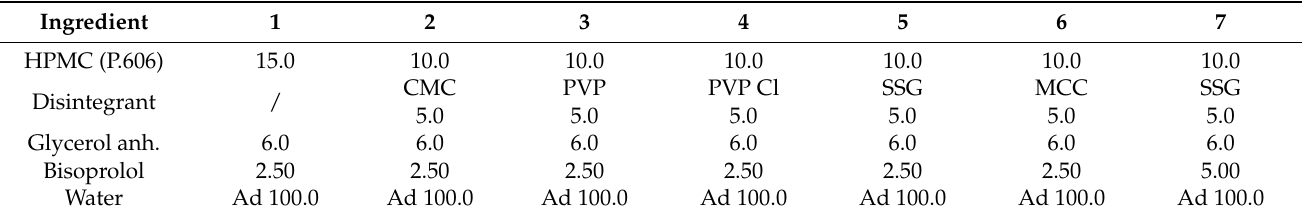
Table 3. Composition of bisoprolol pre-formulation for disintegration test (% w / w ).